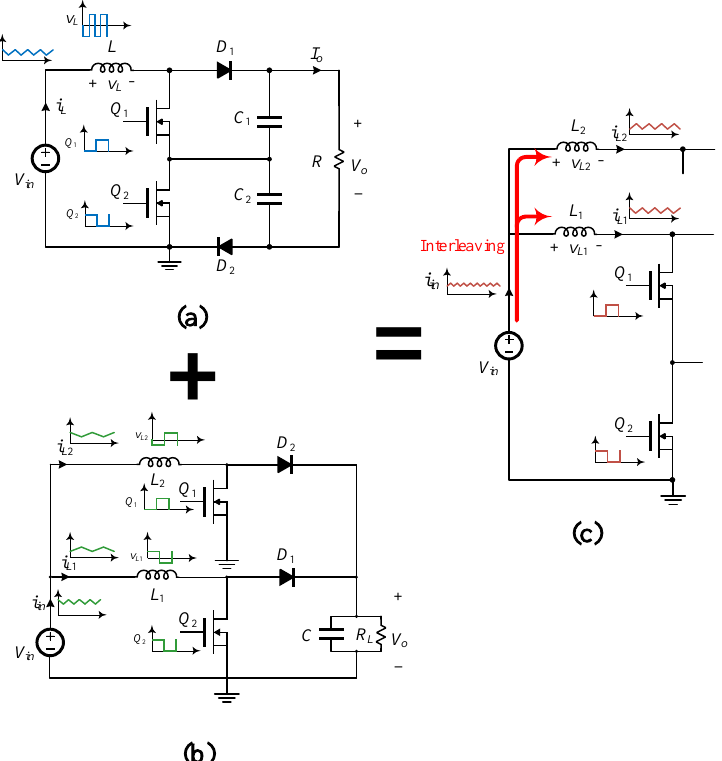
Figure 1. Illustration of an interleaved multilevel converter: ( a ) a three-level converter; ( b ) a two-phase interleaved boost converter; ( c ) an interleaved three-level boost converter. The AC components of the input have a higher frequency than the switching